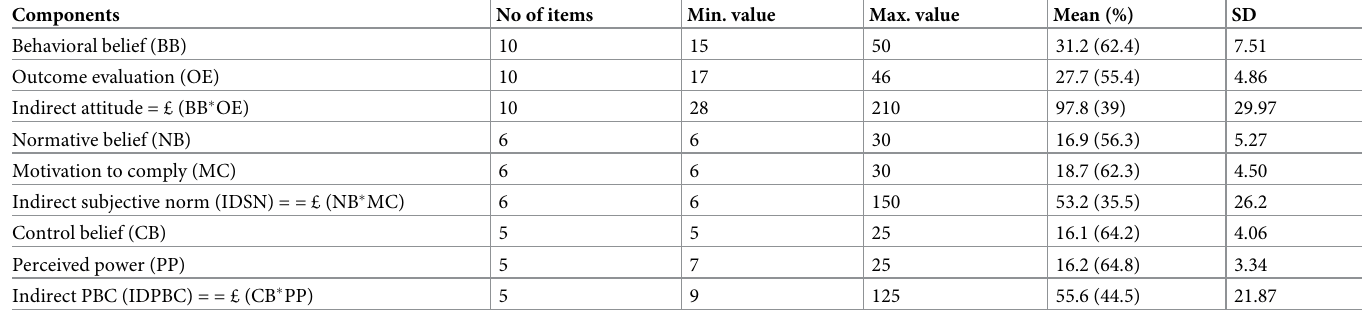
Table 5. Descriptive statistics for the indirect components of the theory of planned behavior model among private college students in Jimma town, Oromia, Ethio- pia, 2019 (n = 595).